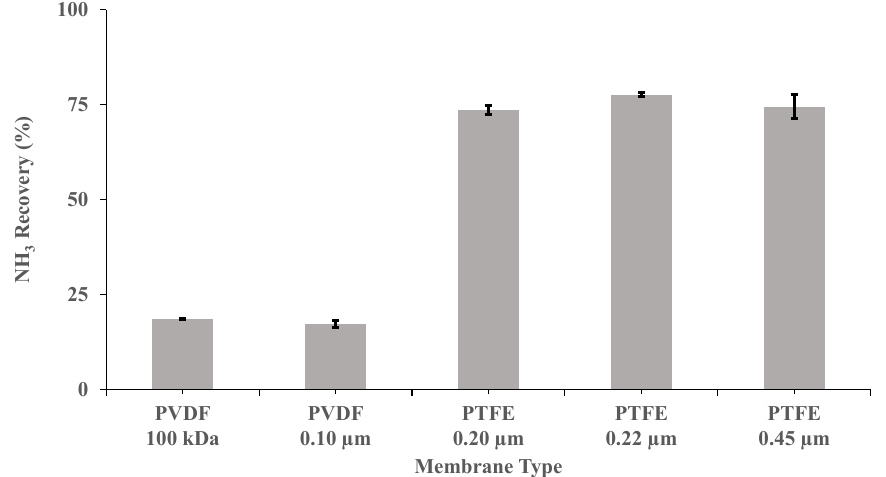
Figure 2. Influence of the type of membrane on ammonia recovery, after 3.5 h, in SD with a recirculation flow rate of 0.030 m 3 h − 1 , a pH of 10 and a concentration of H 2 SO 4 of 1 M. Vertical bars represent the standard deviation obtained from duplicate measurements.